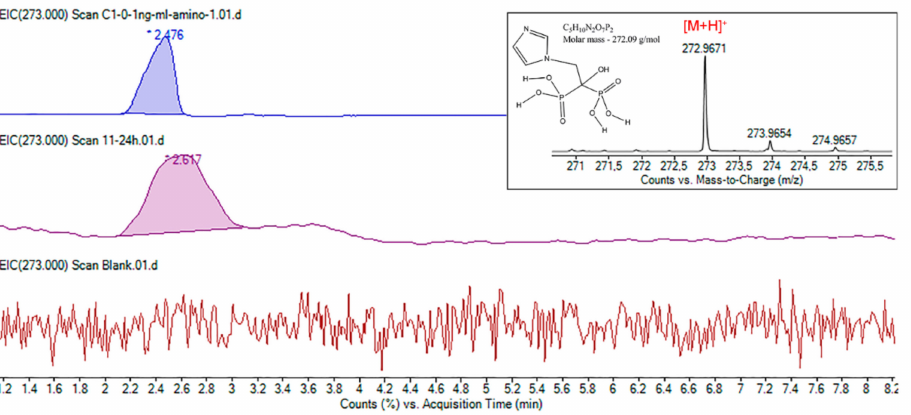
Figure 3. Representative extracted ion chromatograms (EIC) of active compound at m / z 273. Detail: ZA structure confirmation on amino column by